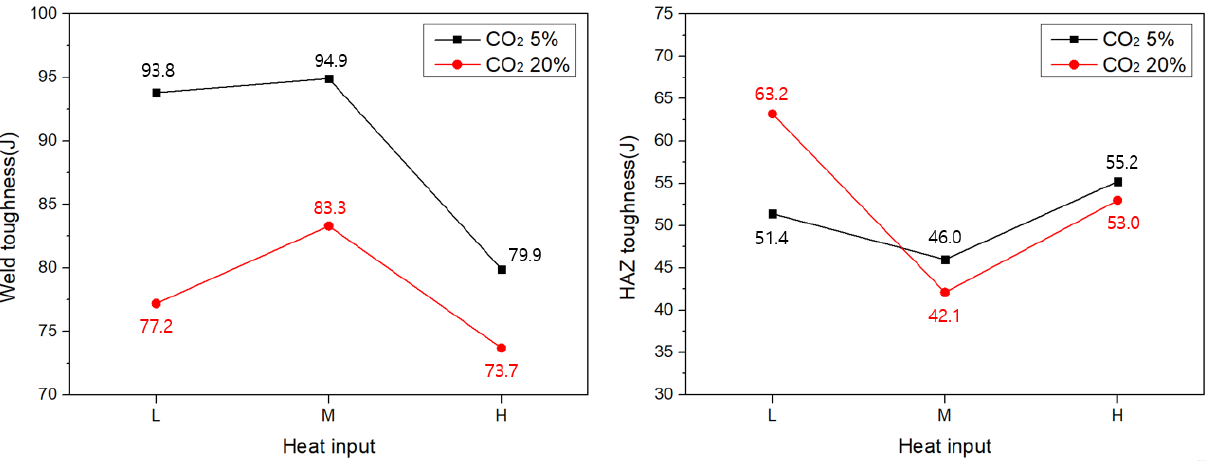
Figure 12. Toughness results of GMAW with CO 2 5% and 20% shielding gas and heat input at room temperature (20 °C).